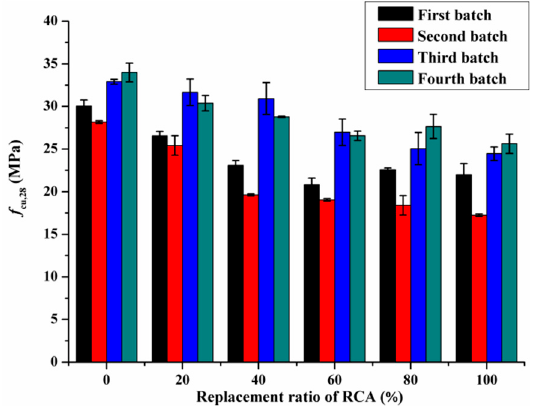
Figure 3. The f cu, 28 of specimens versus the replacement ratio of RCA.